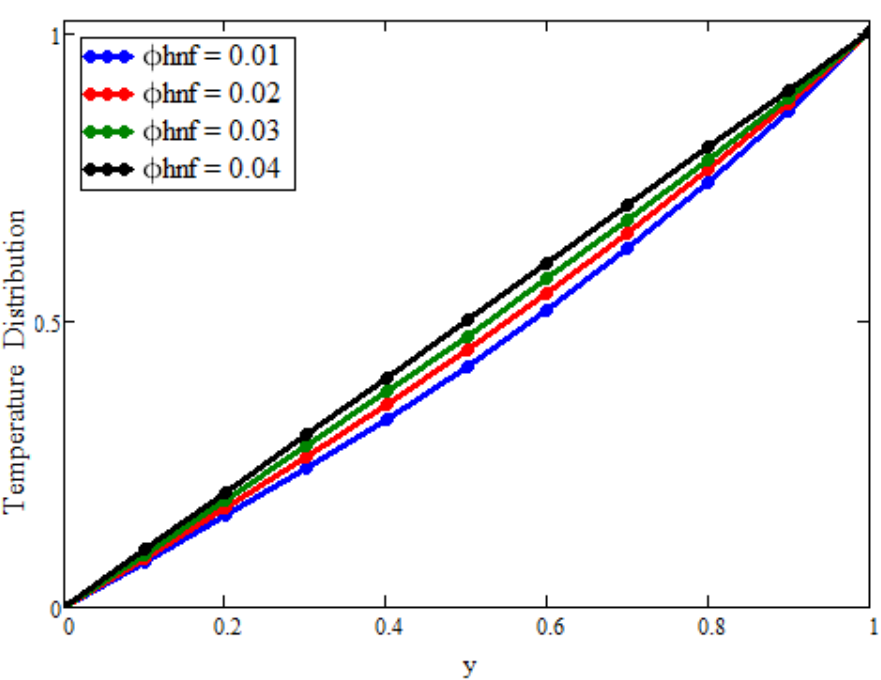
Figure 6. Temperature distribution against y due to φ hnf , when t = 3 , Pr = 6.2, α = β = γ = 0.5.